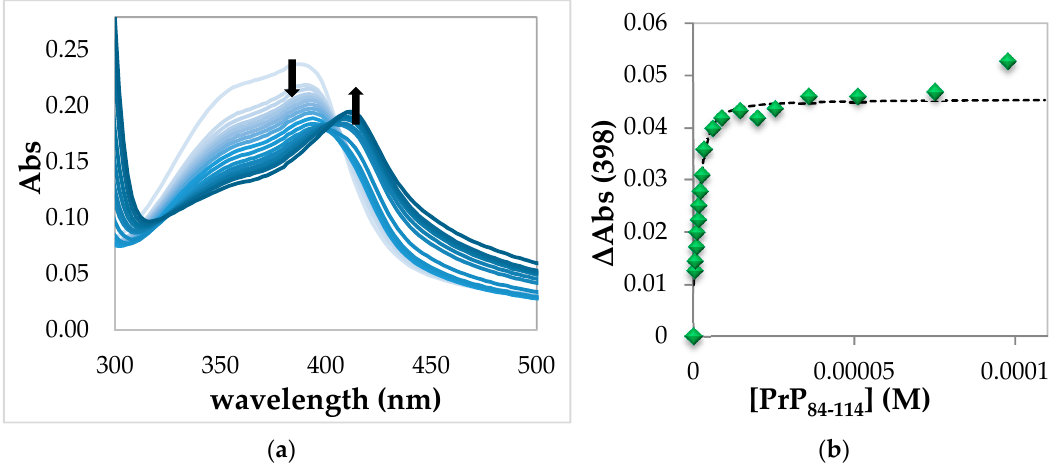
Figure 3. ( a ) UV–Vis spectrophotometric titrations in 20 mM phosphate buffer solution, pH 7.4, showing the decrease in intensity of the Soret band upon binding of hemin (2.80 μ M) with PrP 84–114 (from 0 to 40 equiv., light blue to blue) in a cell of 1 cm path length. The arrow pointing down at 390 nm indicates the hypochromic effect due to the formation of a high-spin hemin-PrP complex; the arrow pointing up at 416 nm indicates the incipient formation of a low-spin complex; ( b ) absorbance changes with respect to free hemin at 398 nm vs. PrP 84–114 concentration fitted by high-affinity equation described in the Materials and Methods section (the sign of Δ Abs (398) has been changed in order to obtain positive values).